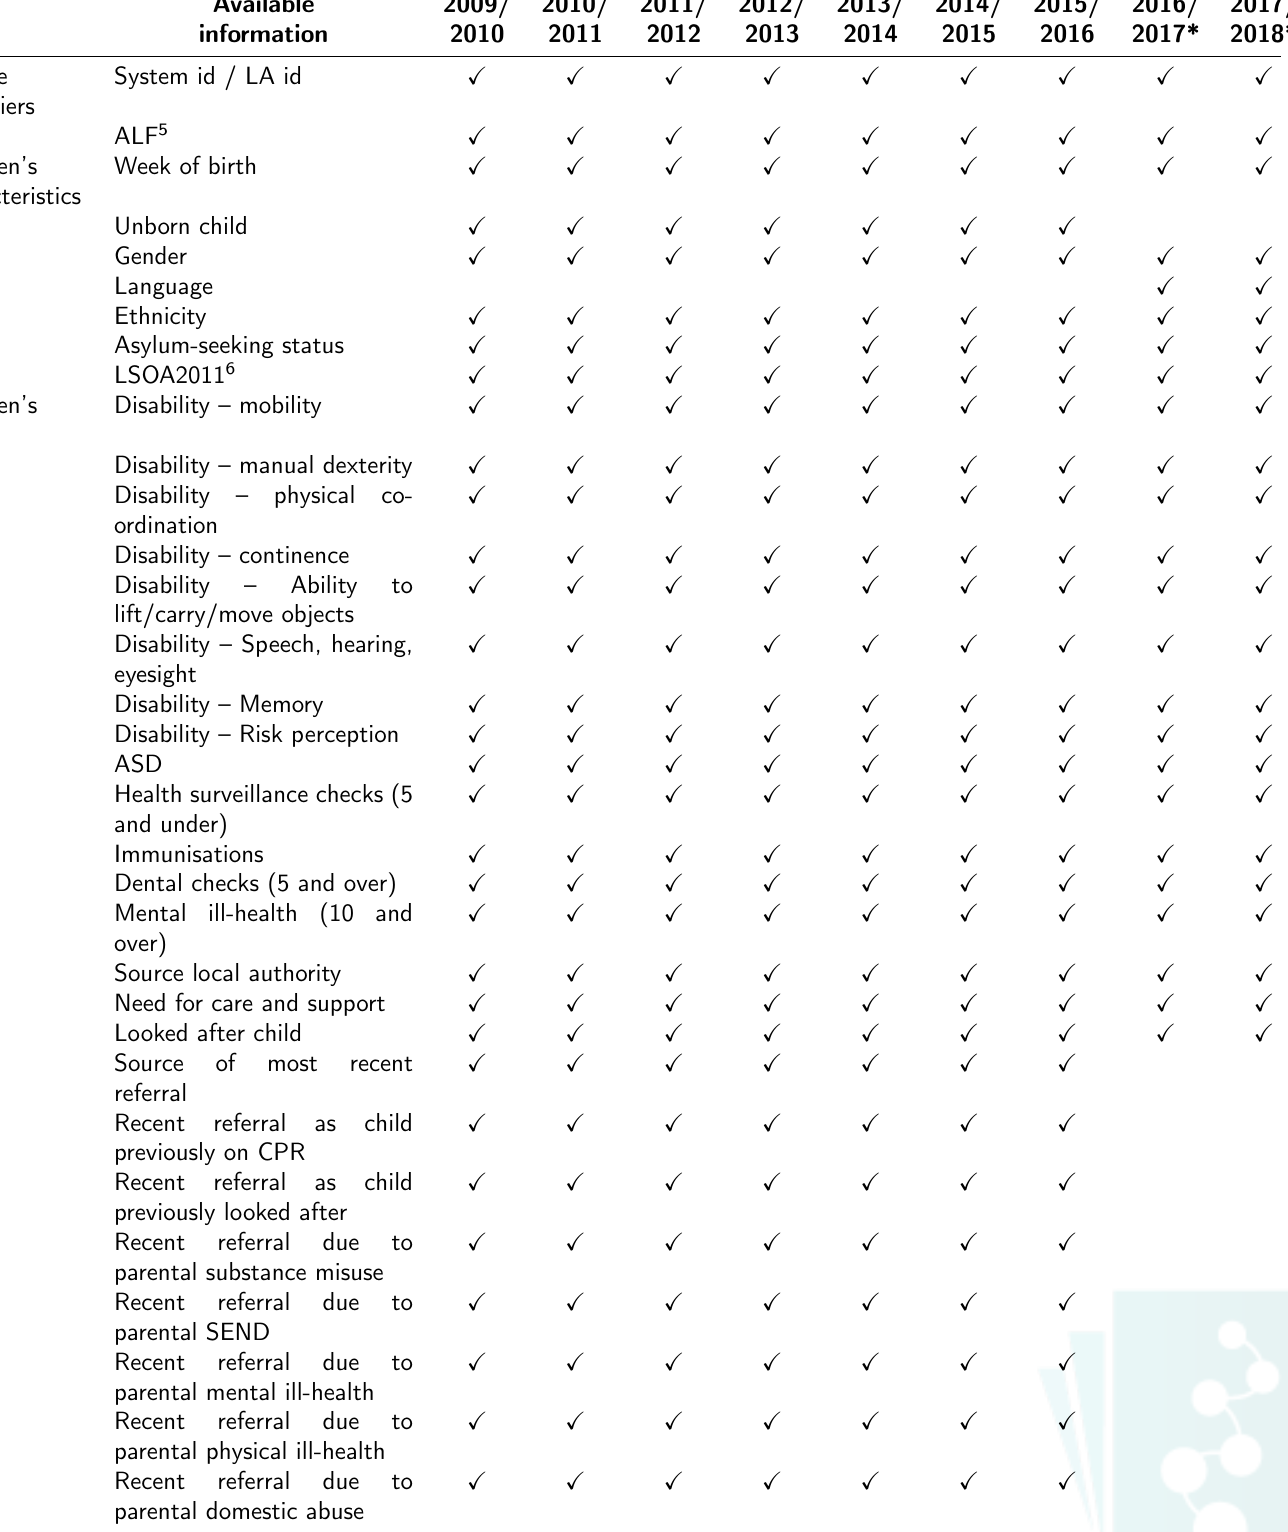
Table 6: Most data items are present across all years, though there are varying levels of data quality per year